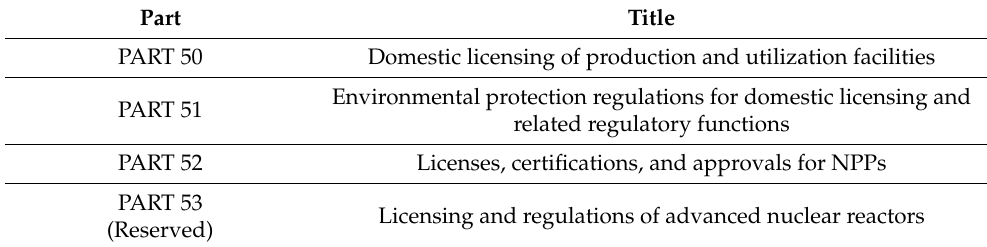
Table 1. List of U.S. NRC 10 CFR Part related to licensing commercial nuclear reactors.